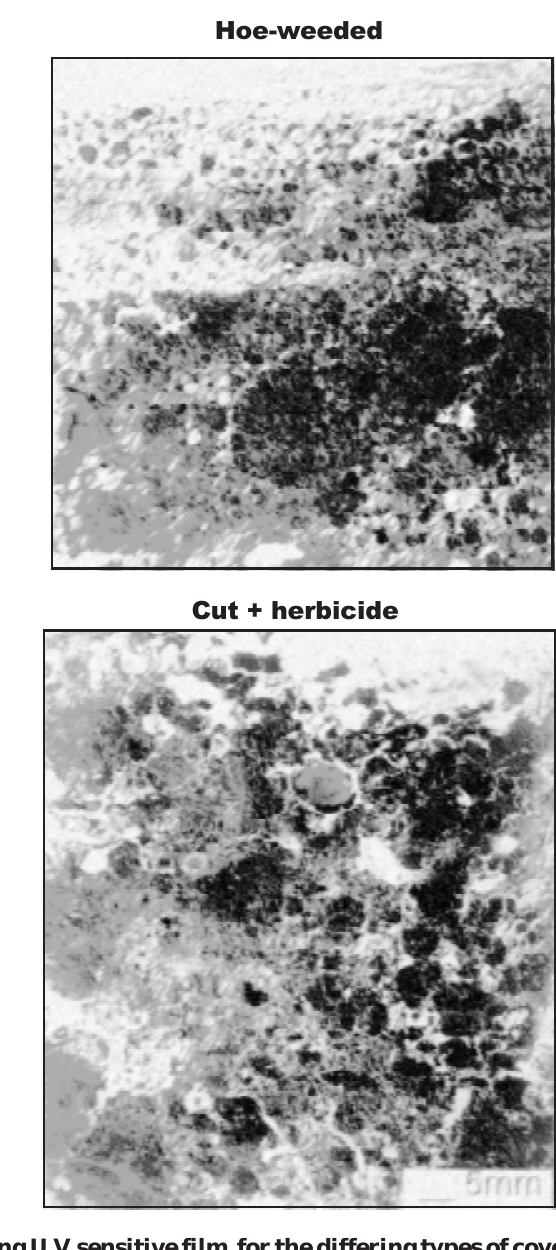
Figure 2. Photographs (1:1 scale) of polished blocks using U.V. sensitive film, for the differing types of